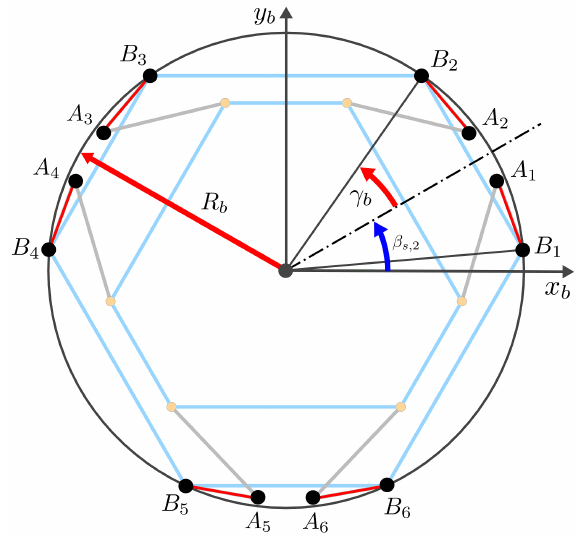
Figure 5. Geometric parameters of the mechanism’s base.